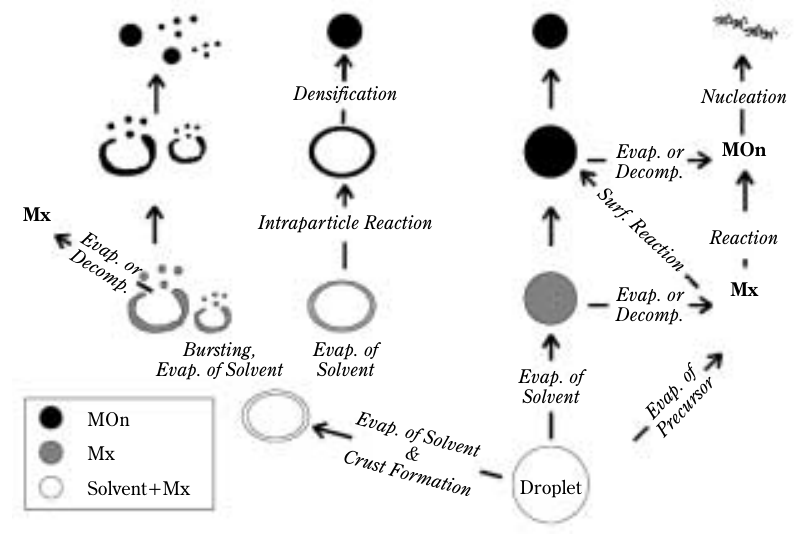
Various mechanisms for metal oxide formation from dissolved metal precursors sprayed into a high-temperature reaction zone. Only mechanisms on the right-hand side lead to nano-grained particles (by precursor evaporation or decomposition at high temperatures), while formation of the product within the droplet environment often leads to hollow and/or larger particles (partly adapted from Kodas and Hampden-Smith